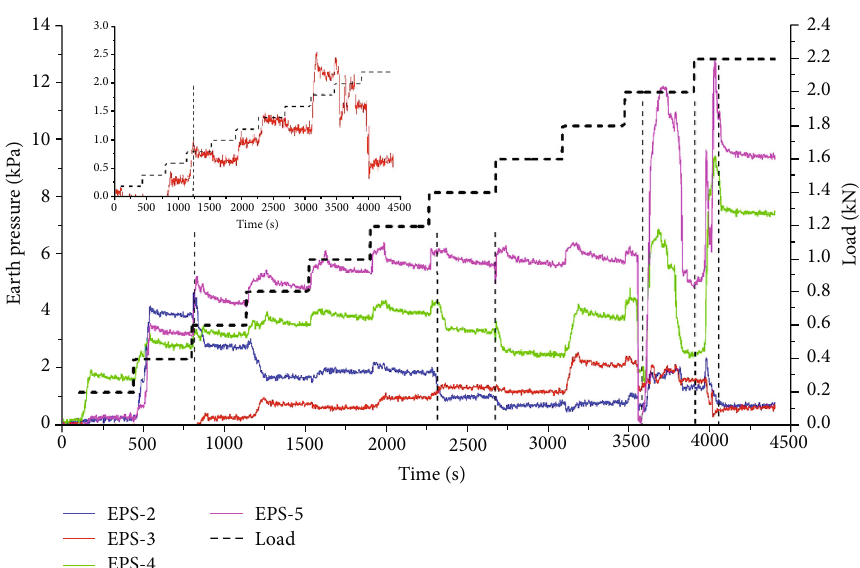
Figure 8: Curves of earth pressure and load.